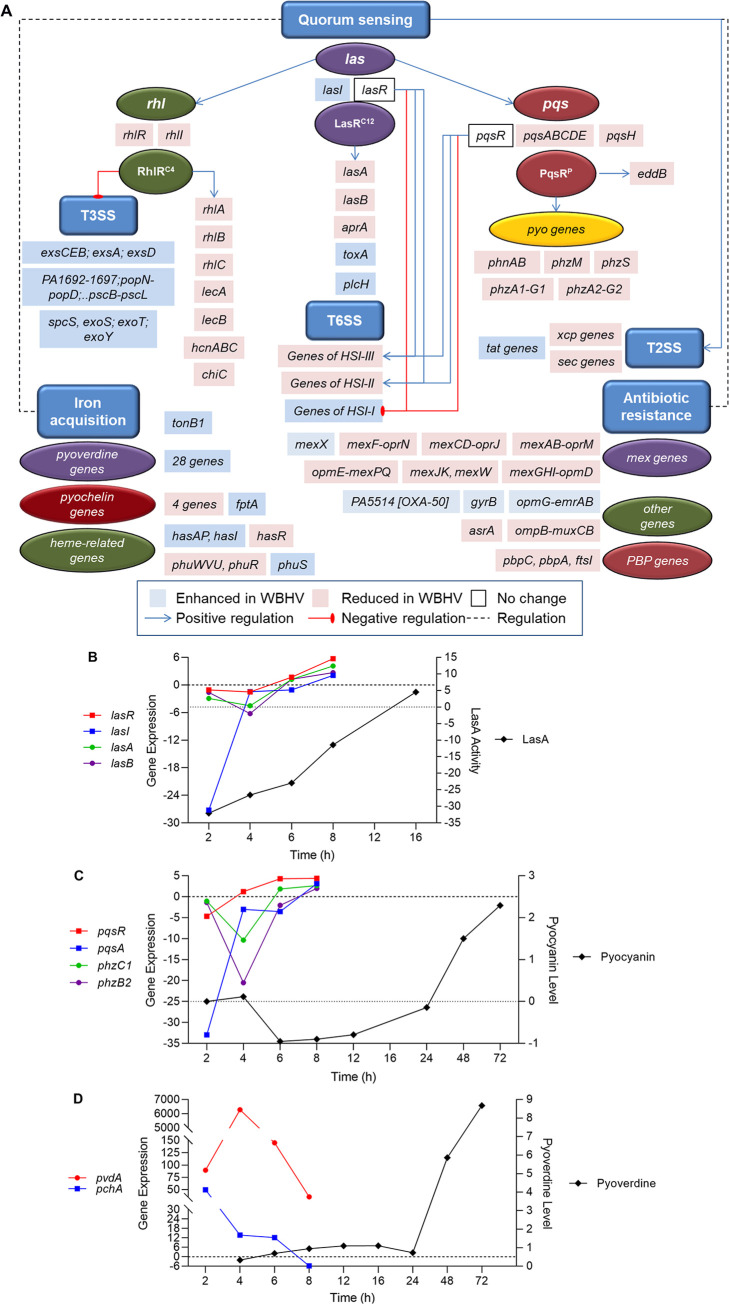
Summary diagrams of the QS and QS-related genes and systems affected by growth of P. aeruginosa in WBHV or PHS.(A) Growth in WBHV for 4 h affected expression of genes of the las, rhl, and pqs QS systems and their related virulence genes as well as genes of the T2SS, T3SS, and T6SS, genes for iron acquisition, and genes for antibiotic resistance. See embedded legend for description of symbols used in figure. HSI-I, HSI-II, HSI-III: Hcp secretion islands I, II, and III, respectively. (B, C, D) Growth in PHS revealed temporal changes in genes expression and production of virulence factors. Gene expression (left y-axis, 0 indicated by dashed line) is shown as fold change (WBHV to LBB). The related virulence factor (right y-axis, 0 indicated by dotted line) is shown as change in production in WBHV over (or under) the production of that factor in LBBS. (B) Expression of genes of the las system and LasA activity. (C) Expression of genes of the pqs system and pyocyanin production. (D) Expression of genes for pyoverdine and pyochelin synthesis and pyoverdine production.